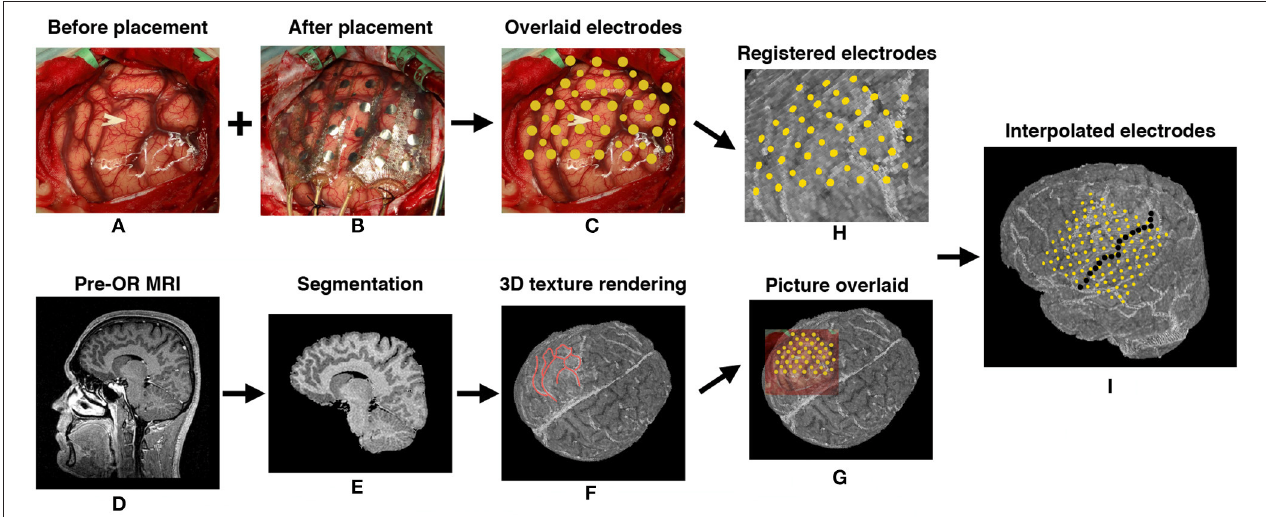
FIGURE 4 | Intraoperative photo based electrode registration procedure for P2. (A) Cortex photo before electrode placement. (B) Photo taken from the same position after electrode placement. (C) Electrodes (disks in gold) manually segmented out and overlaid on the cortex. (D) Patient’s preoperative MRI. (E) Gray and white matter segmentation. (F) 3D texture rendering of gray and white matter. Blood vessels were accentuated by red lines as landmarks. (G) Picture overlaid on 3D rendering by comparing the landmarks. (H) Electrodes registered on 3D rendering of the brain. (I) The side view of the cortex with registered and interpolated electrodes, central sulcus was delineated by a series of discrete black